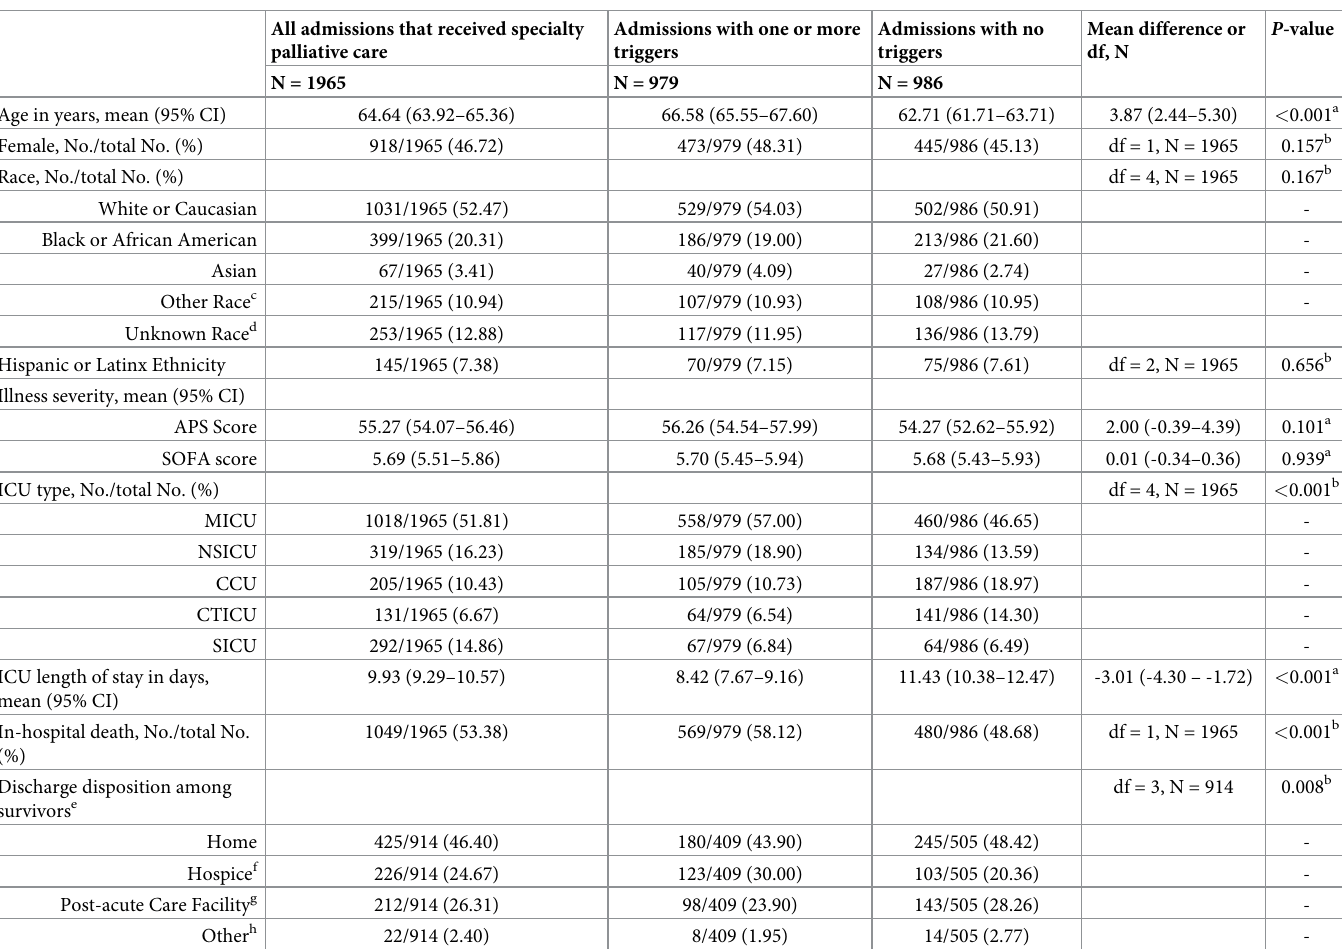
Table 1. Demographics, clinical characteristics, and hospitalization outcomes of intensive care unit admissions who received specialty palliative care consultation in the intensive care